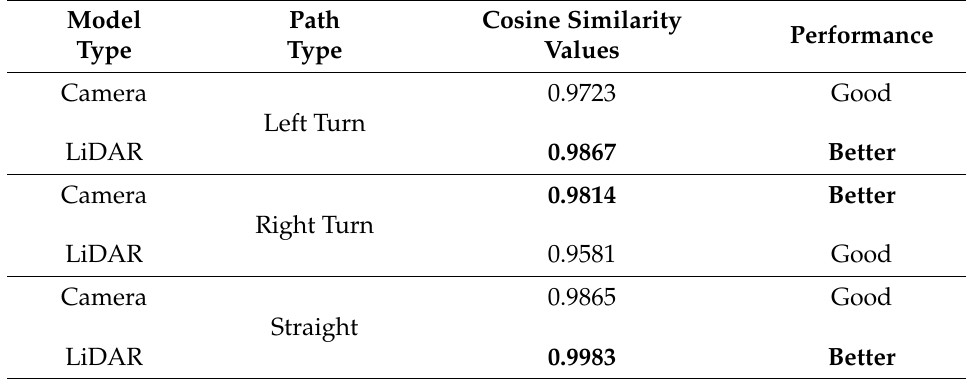
Figure 25. Ridon vehicle entering a right turn path while driving autonomously. ( a ) Using camera model. Video: https://youtu.be/yDkAi2VFYX0 (accessed on 18 November 2021). ( b ) using LiDAR model. Video: https://youtu.be/KYO76NHjP44 (accessed on 18 November 2021) . Note: Although the LiDAR model is used in ( b ), the re-projected LiDAR points are not shown on the image. Table 3. Cosine similarity between the manual and model